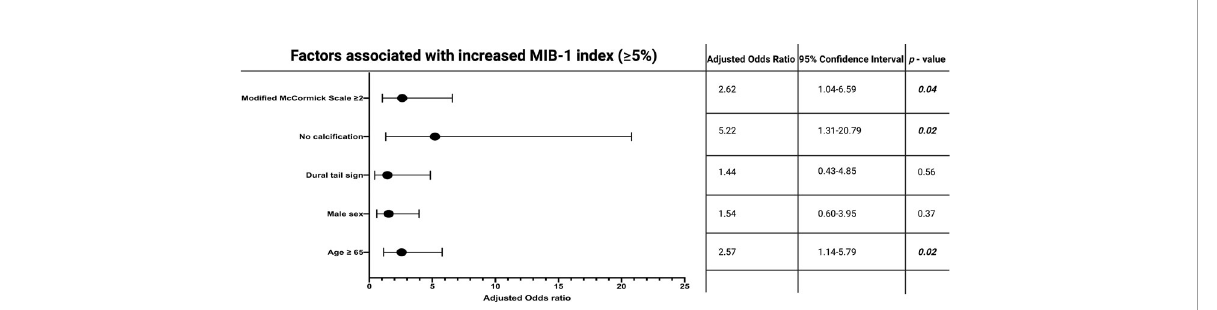
FIGURE 3 Forest plots from multivariable binary logistic regression analysis: Modi fi ed McCormick scale ≥ 2 at presentation, age ≥ 65 years at diagnosis, and absence of calci fi cation are independent predictors of increased MIB-1 labeling index. Black circles indicate the adjusted odds ratio of each variable and the lines represent the corresponding 95% con fi dence interval. P -values in bold and italics display statistically signi fi cant results.